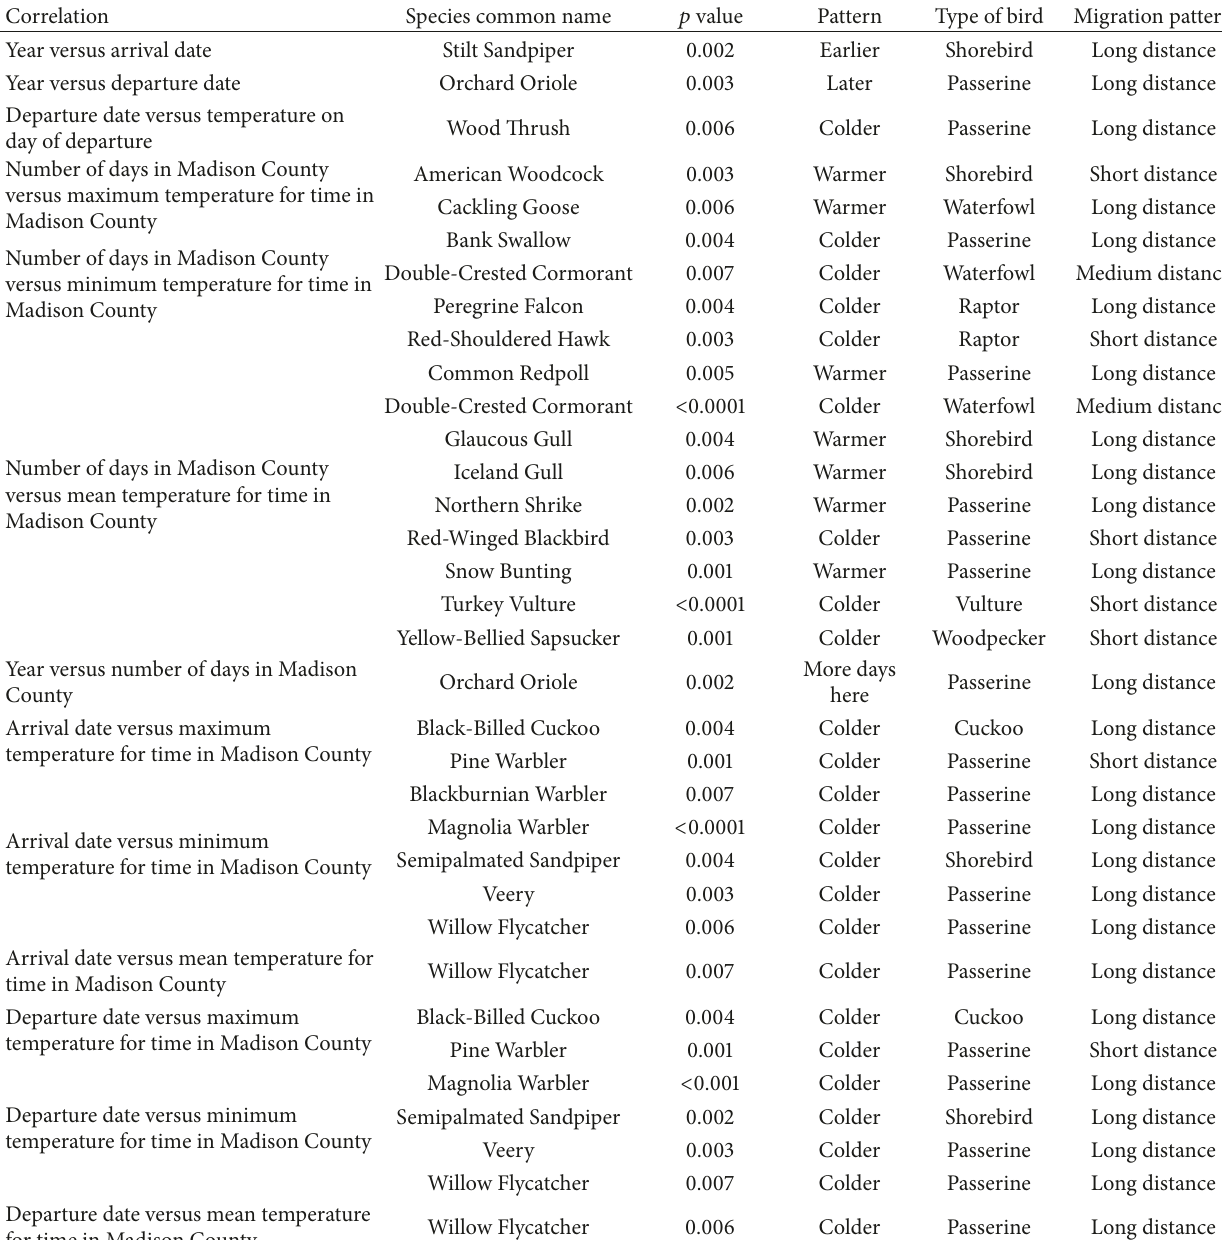
Table 1: Migration timing changes and significant environmental temperature changes experienced by species showing a one-stopover migration strategy through Madison County. Migration patterns were determined using data from the Cornell lab of ornithology and Zuckerberg et al.